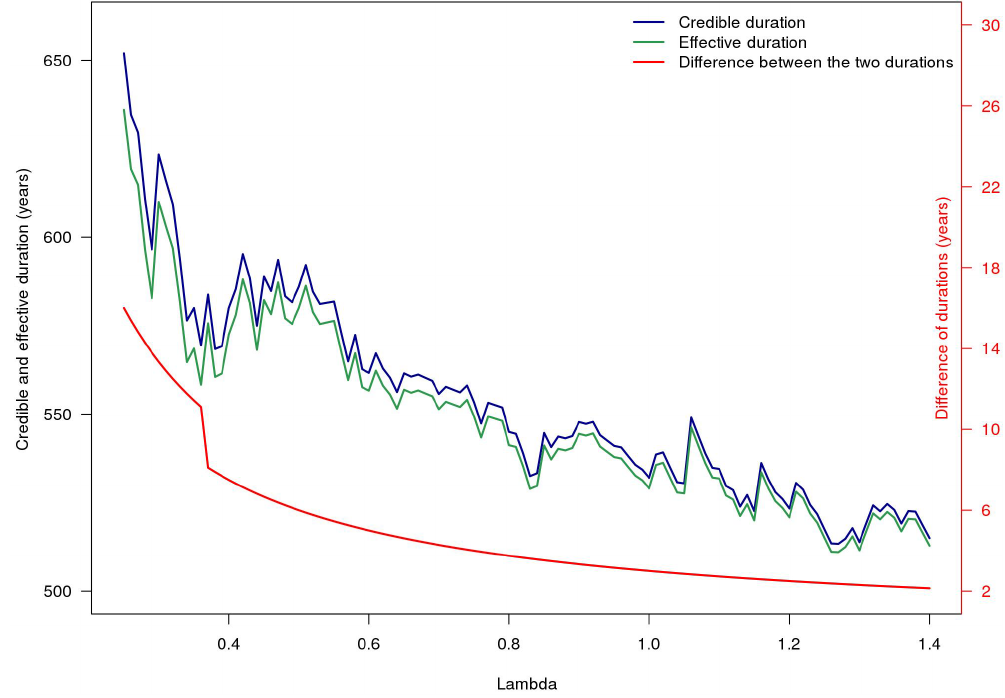
Figure 6. Variation in regional credible duration (taking into account the nine historical data) and regional effective durations (only with systematic data) and their difference (in red) for Region 1.